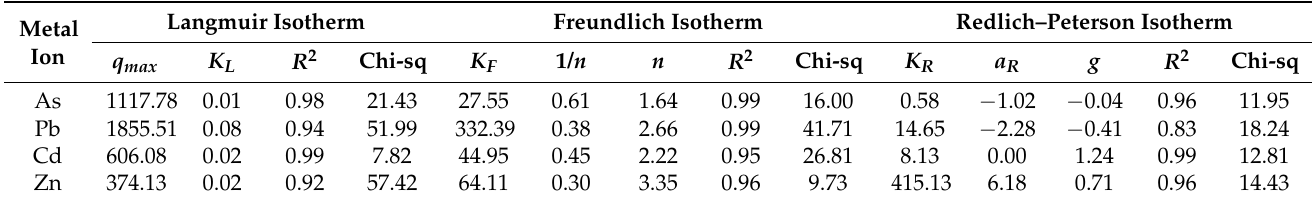
Table 5. Adsorption isotherm parameters for the composite.